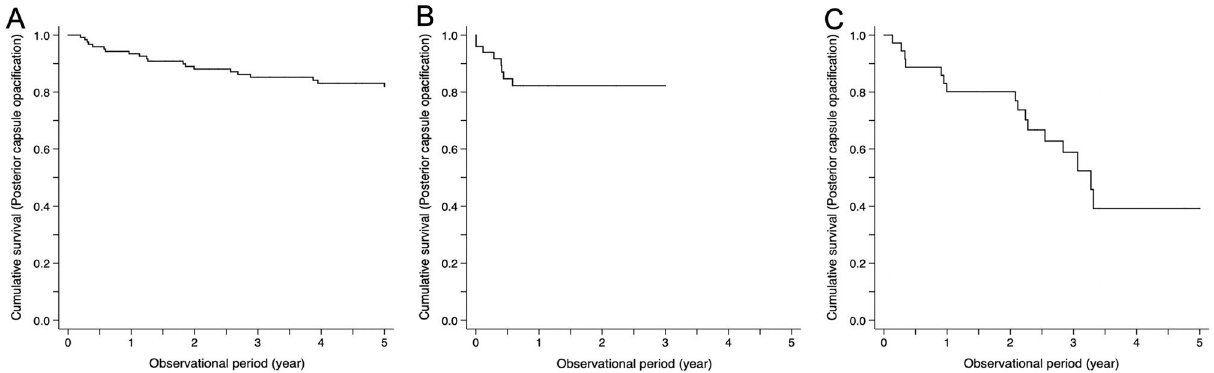
Figure 1. Cumulative survival curves of posterior capsule opacification (PCO). ( A ) Acrysof group. ( B ) iSert XY-1 group. ( C ) iSert 251/255 group. A difference is observed at the initial time point, with the Acrysof group exhibiting a significantly lower incidence of PCO than the iSert XY-1 and iSert 251/255 groups over the 5 years (log-rank test, p <